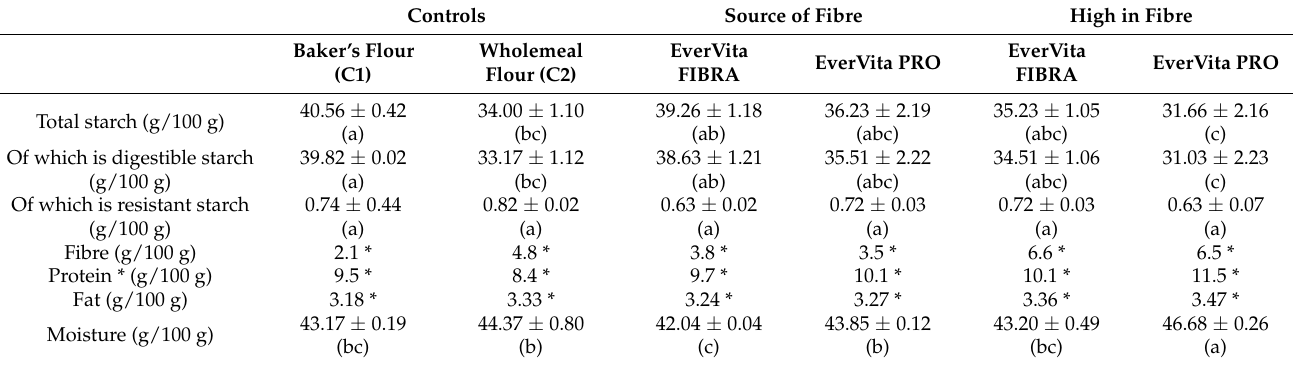
Table 4. Starch, dietary fibre, protein, fat and moisture content of bread samples. Values represent the means ± standard deviation. Total starch (g/100 g)